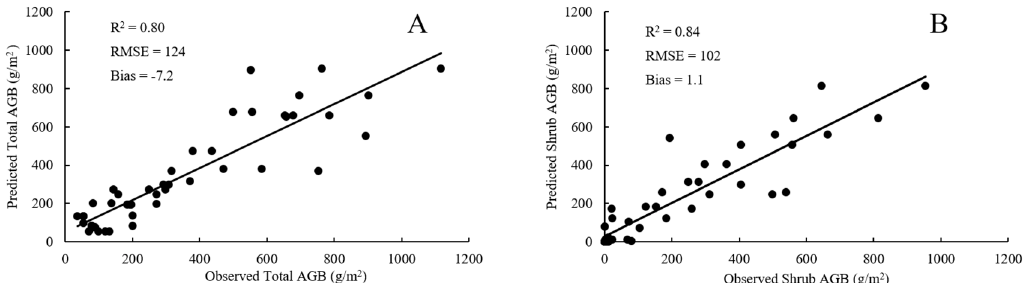
Figure 4. Scatterplots between the observed AGB (field-measured biomass) and the predicted AGB with the RF regression model for total ( A ) and shrub ( B ) biomass.